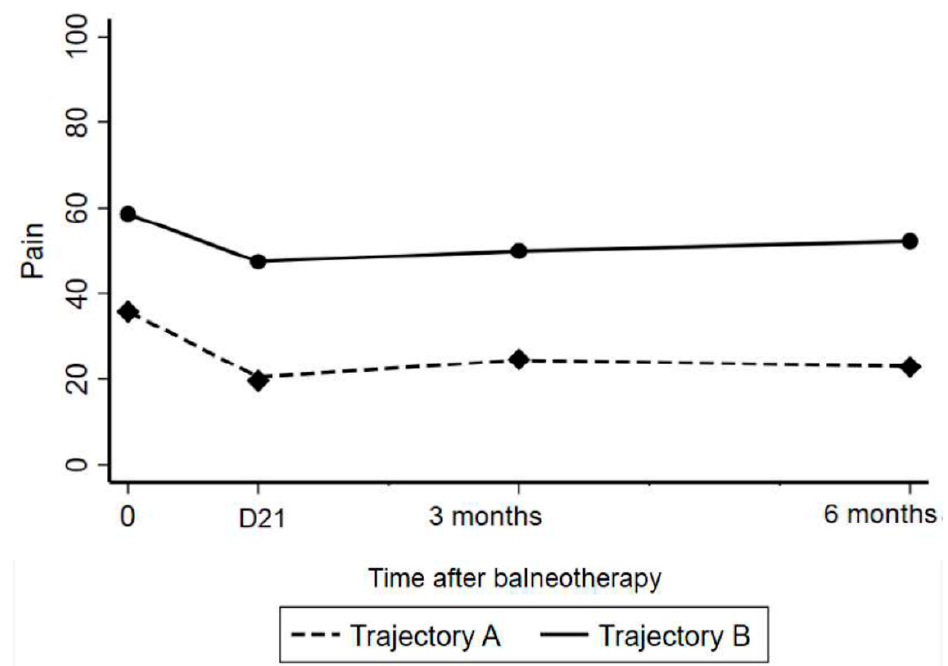
Figure 2. Change in pain intensity from the start of balneotherapy until the 6-month follow-up for both pain trajectories.